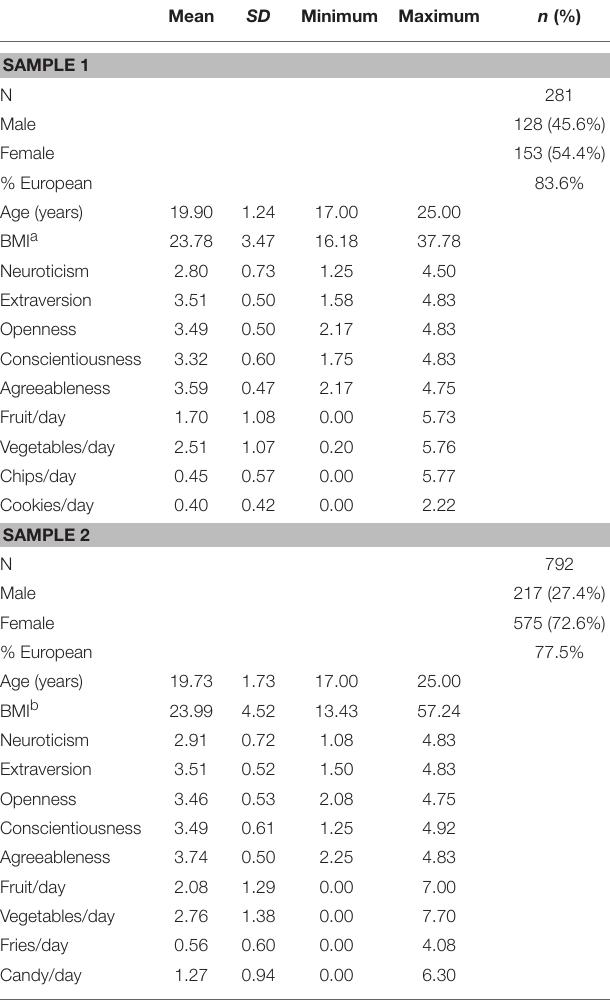
TABLE 1 | Participant characteristics and descriptive statistics for the two samples of young adults.